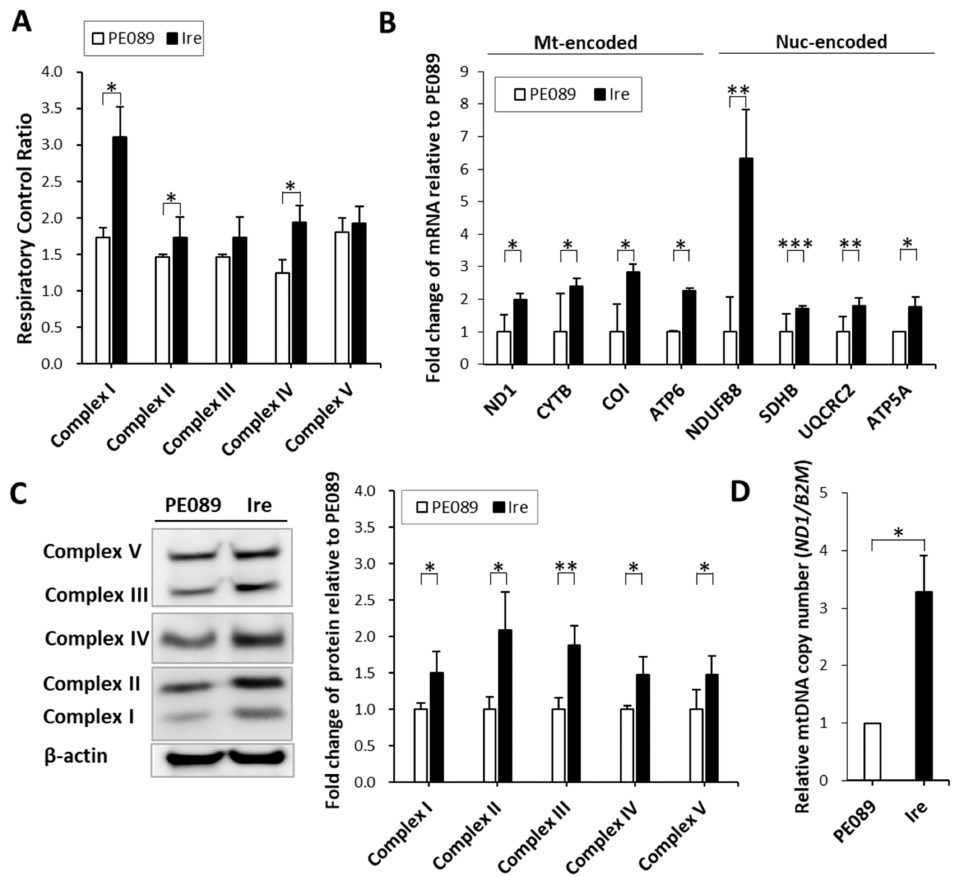
Figure 4. Representative changes in the respiratory activity and the transcripts and protein levels of mitochondrial respiratory complexes. ( A ) Mitochondrial complexes activity was analyzed by Seahorse XF24 analyzer. ( B ) The di ff erential changes in the transcripts of mitochondria-encoded respiratory complex genes ( ND1 , CYTB , COI and ATP6 ) and nucleus-encoded respiratory complex genes ( NDUFB8 , SDHB , UQCRC2 and ATP5A ) were measured by qPCR. The expression levels were normalized to an internal control ( ACTB ) and fold changes were relative to the control. ( C ) Immunoblots of